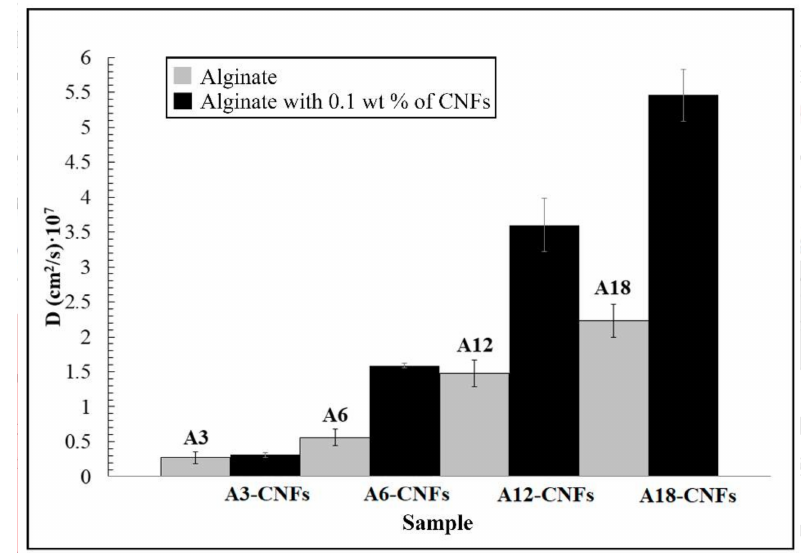
Figure 2. Apparent diffusion coefficients ( D ) of liquid water in the alginate hydrogels (grey columns) and in the composite alginate hydrogels with 0.1% w/w of CNFs (black columns) with the indicated cross-linker contents (3, 6, 12 and 18% w/w ). Data are represented as mean ± standard deviation.